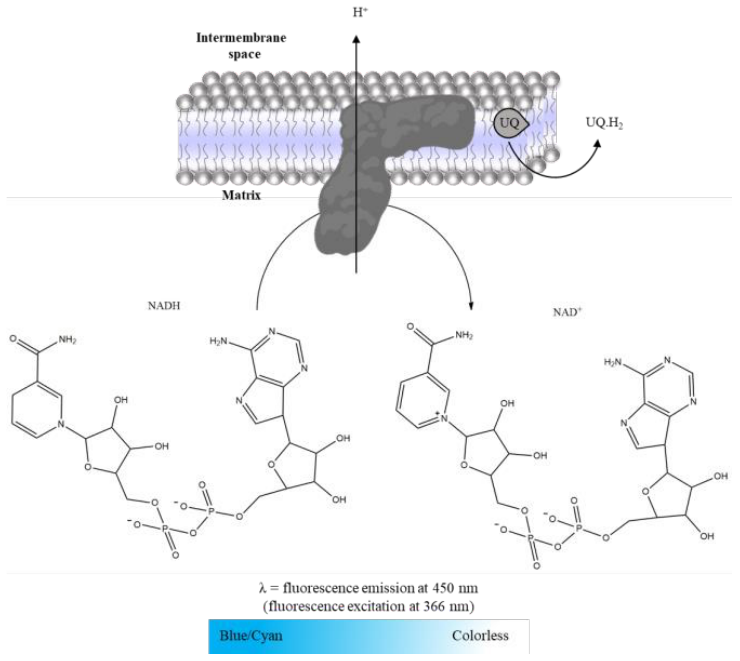
Figure 7. Oxidation of NADH to NAD+, measured at 450nm (setting excitation at 366 nm). Table 5. Conditions and flow setup for Complex I activity assay.